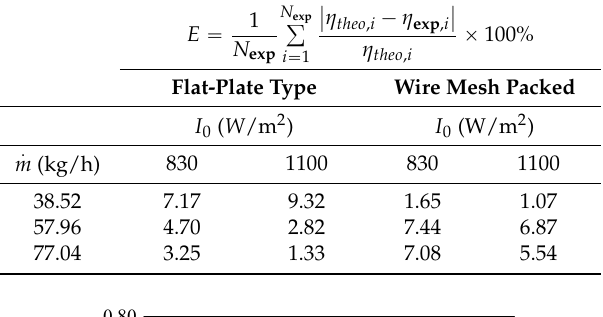
Table 1. Deviations between the experimental results and theoretical predictions.